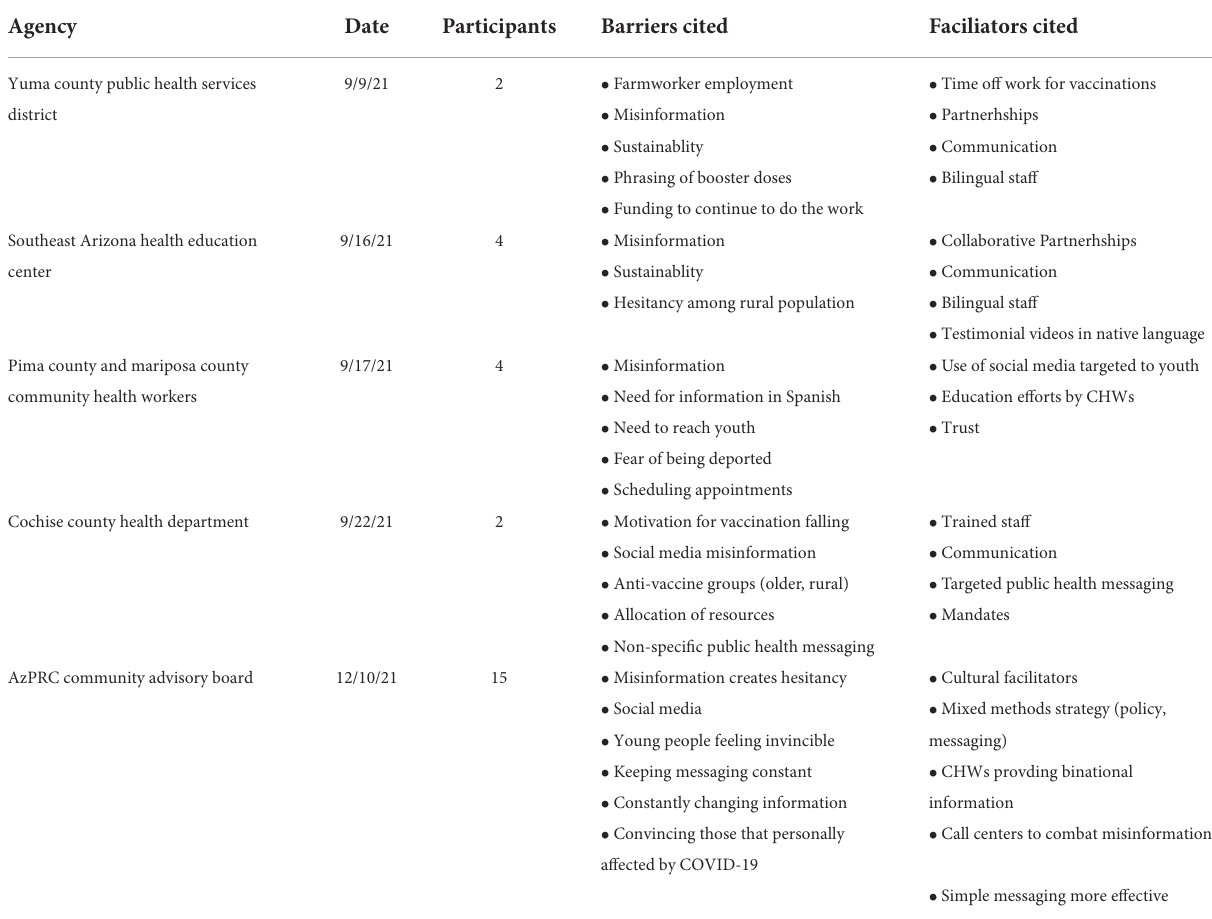
TABLE 1 Listening session